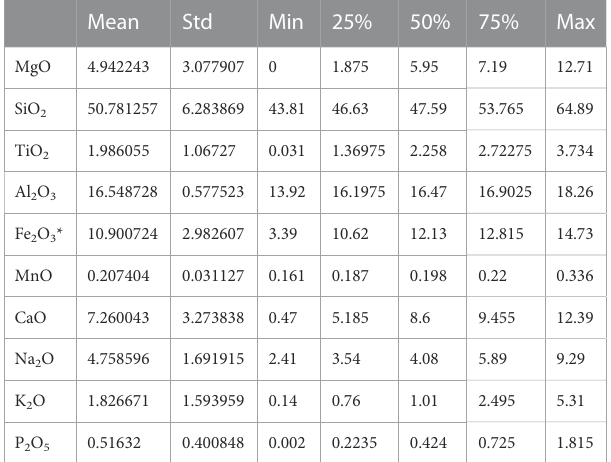
TABLE 7The statistical analysis summary of the NorthernHarrat Rahat Region.